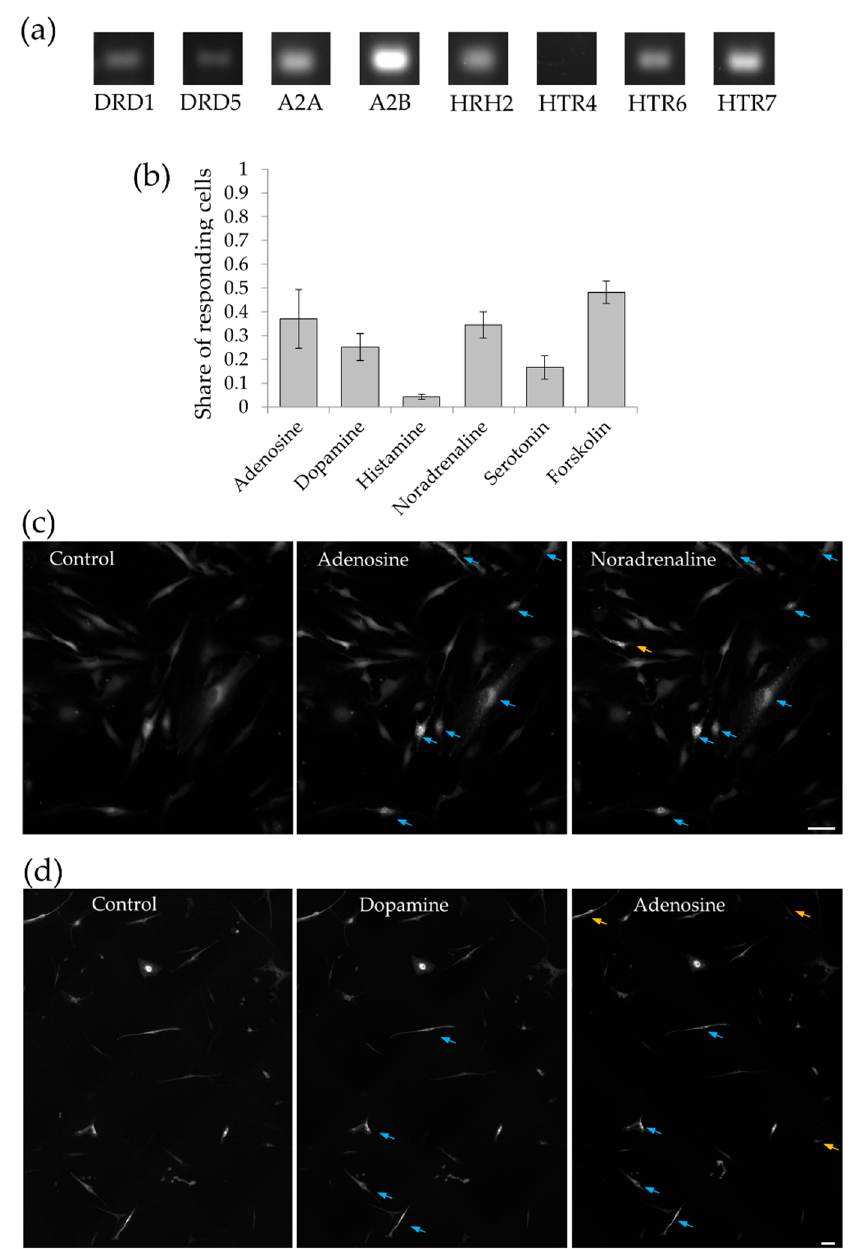
Figure 2. MSC express functionally active receptors activating PKA-dependent signaling. ( a ) PCR analysis of expression of cAMP-dependent receptors to dopamine (DRD1 and DRD5), adenosine (A2A, A2B), histamine (HRH2), and serotonin (HTR6 and HTR7, but not HTR4). ( b ) Share of MSC responding to the hormones with activation of PKA. Mean ± SE, n = 4–12 independent experiments on the cells isolated from 3 different donors. ( c,d ) Sequential adding of PKA-activating hormones. The next hormone was added after washing the previous one. Blue arrows mark the cells responded to the first hormone added. Yellow arrows show the cells additionally responded to the second hormone added. Scale bar 100 µm.